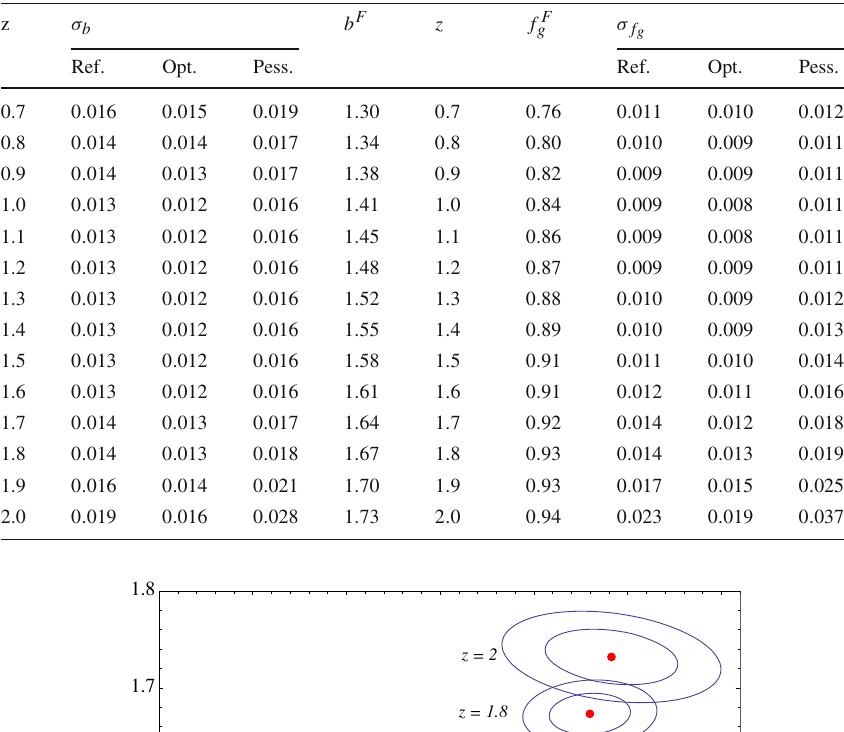
Table 4 1 σ marginalized errors for the bias and the growth rates in each redshift bin